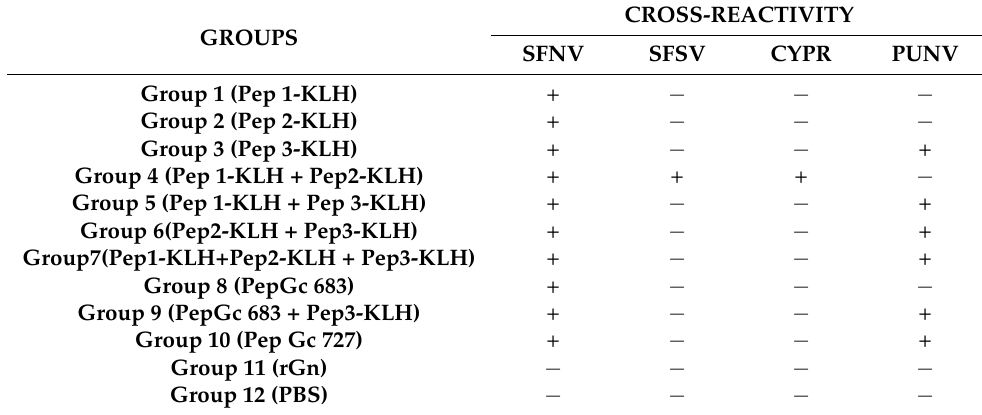
Table 4. Cross-reactivity among mice sera and SFNV, SFSV, CYPR, PUNV Phleboviruses.